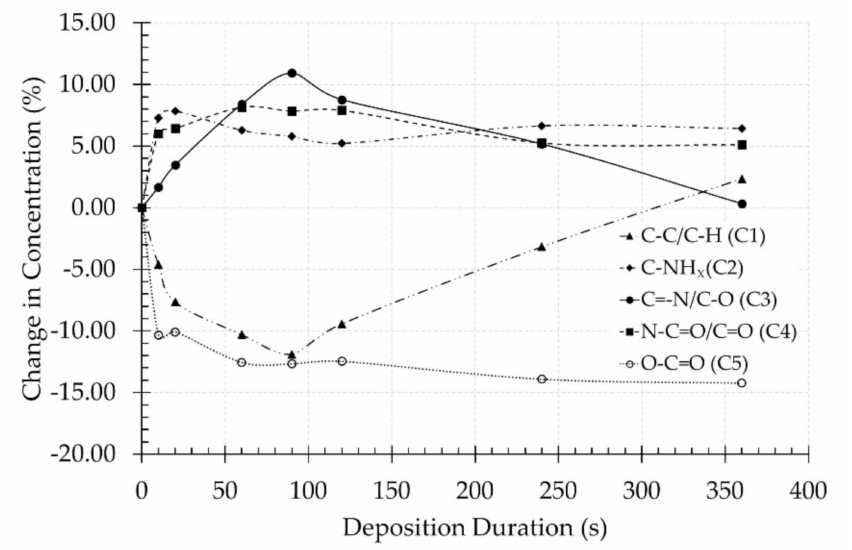
Figure 6. Changes in chemical bond concentrations between untreated PCL NFs and PPF-NFs as a function of plasma deposition